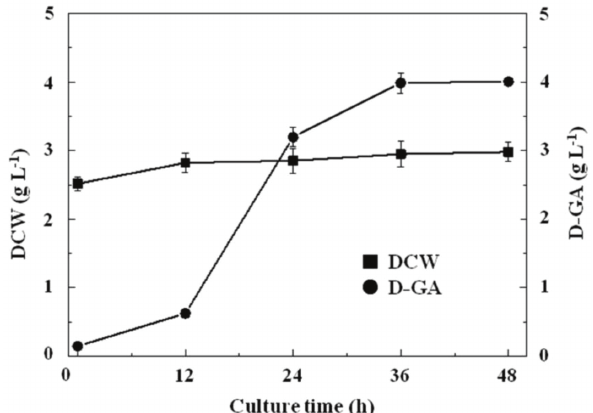
Fig. 2 – Effect of culture time on cell growth and D-GA yield